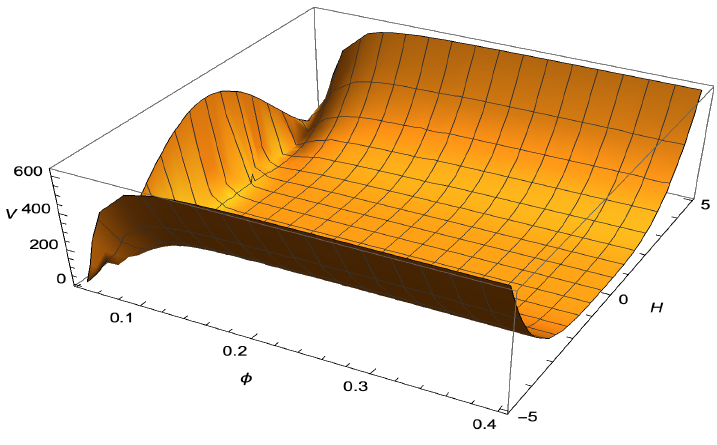
Figure 4 . The 4D scalar potential as a function of brane separation φ and the tachyon H .